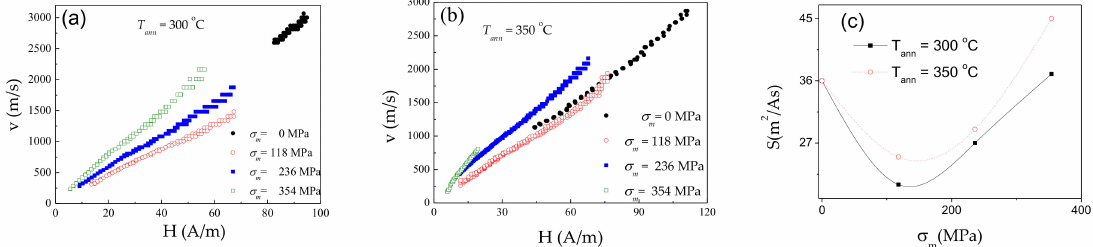
Figure 8. v(H) dependenciesofannealedat T ann = 300 ◦ C( a )and350 ◦ C( b )Co 69.2 Fe 3.6 Ni 1 B 12.5 Si 11 C 1.2 Mo 1.5 microwires and S ( σ m ) dependencies for the same microwires ( c